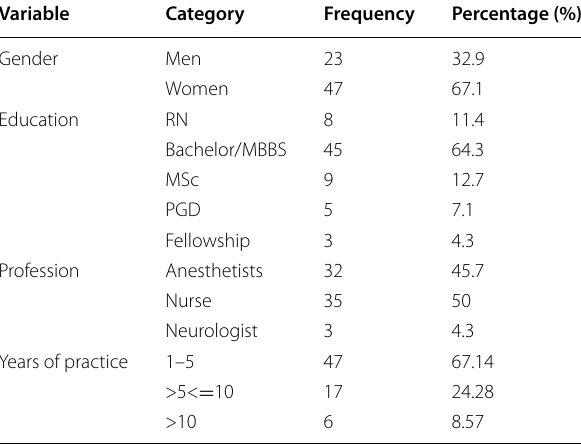
Table 1 Demographical characteristics of the participants